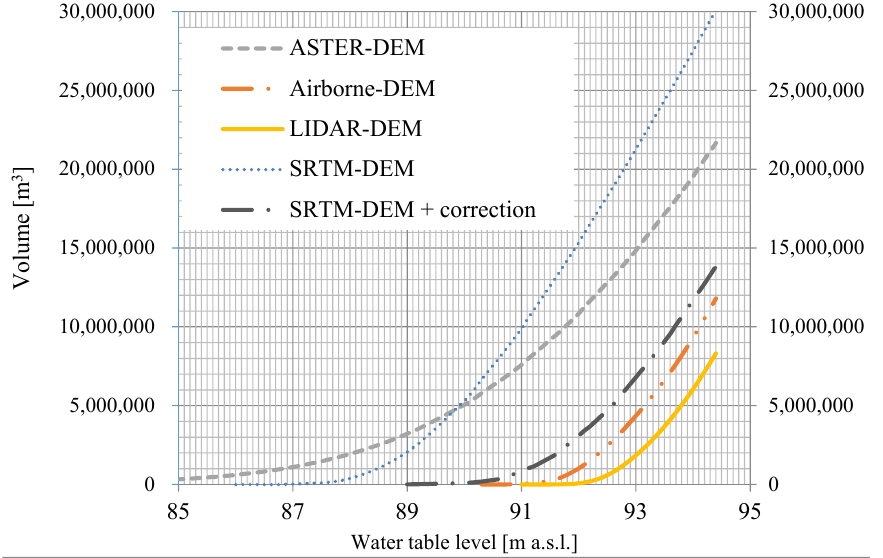
Water table level [m a.s.l.] Water table level [m a.s.l.] Figure 8. Comparison of the volume of the polder as determined for different DEMs. Figure 8. Comparison of the volume of the polder as determined for different DEMs. Figure 8. Comparison of the volume of the polder as determined for different DEMs.